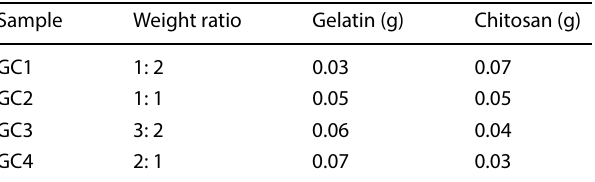
Table 2 Amount of gelatin and chitosan for maintaining different weight ratio Sample Weight ratio